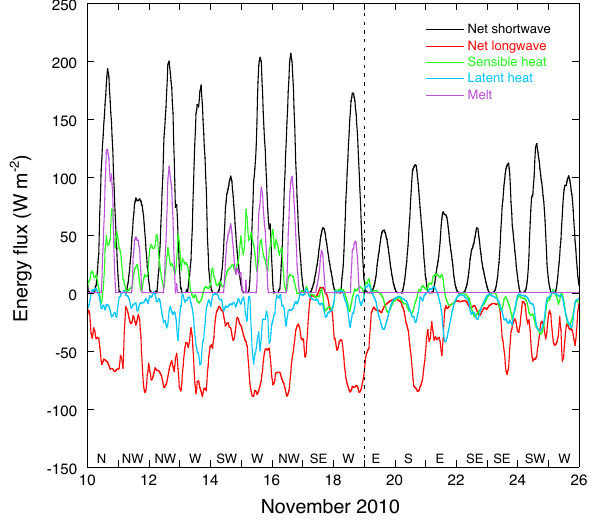
Fig. 13. Selected SEB components between 10 and 26 Novem- ber 2010. Daily-mean wind direction is shown at the bottom of the panel.